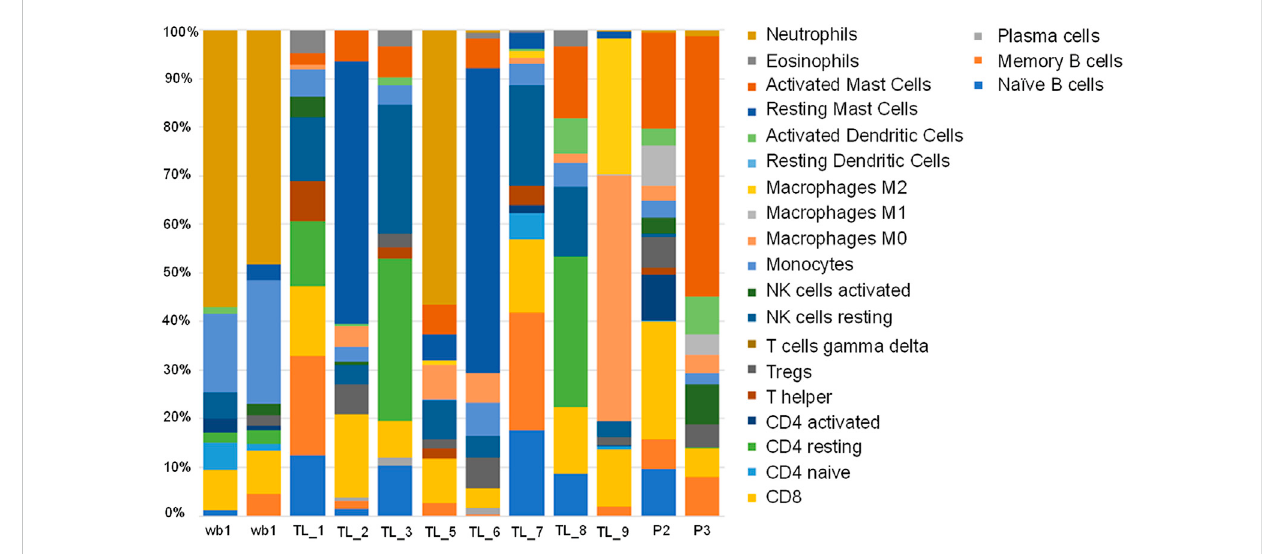
Stacked bar plot depicting 22 immune cell fractions across the control and Acute leukemia samples in terms of